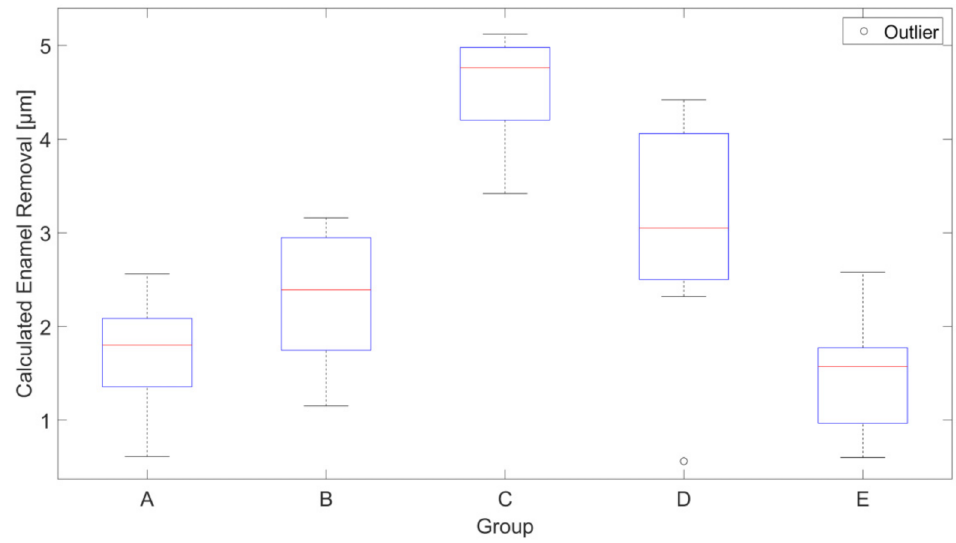
Figure 4. Calculated enamel removal after brushing with different toothpastes. N = 9 for all groups. Groups are A: water, B: Sensodyne Pro Schmelz, C: Splat Blackwood, D: Curaprox Black is White, E: Prokudent Black Brilliant.